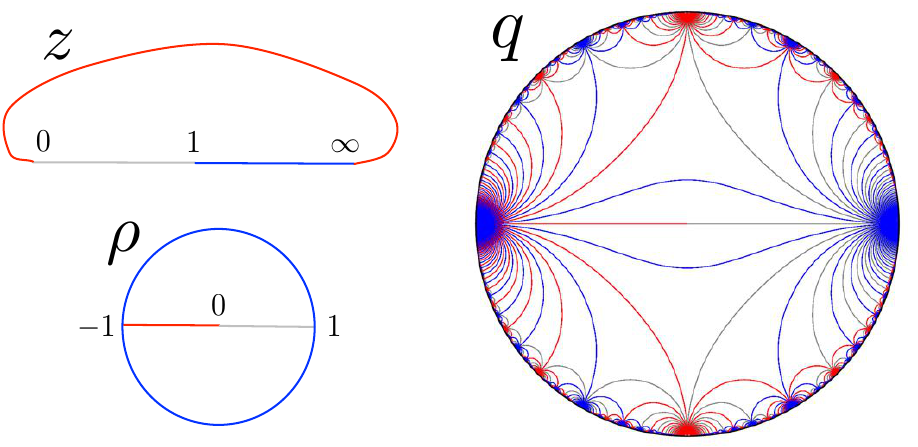
Figure 3 . The q ( z ) map takes the universal cover of the z -plane (the sphere with punctures at 0 ; 1 ; ) to q < 1. This (cid:12)gure suggests the relationship between the z plane, the unit (cid:26) disk, and 1 j j the unit q disk, with branch cuts indicated with colored lines [28]. The relations between these K (1 (cid:0) z ) variables are q = e (cid:0) (cid:25) , and the inverse transformations are z = K ( z ) and z = 4 (cid:26) (1+ (cid:26) ) 2 (cid:26) = z . The Virasoro blocks converge throughout q < 1, with OPE limits occurring on (1+ p 1 z ) 2 j j (cid:0) the q unit